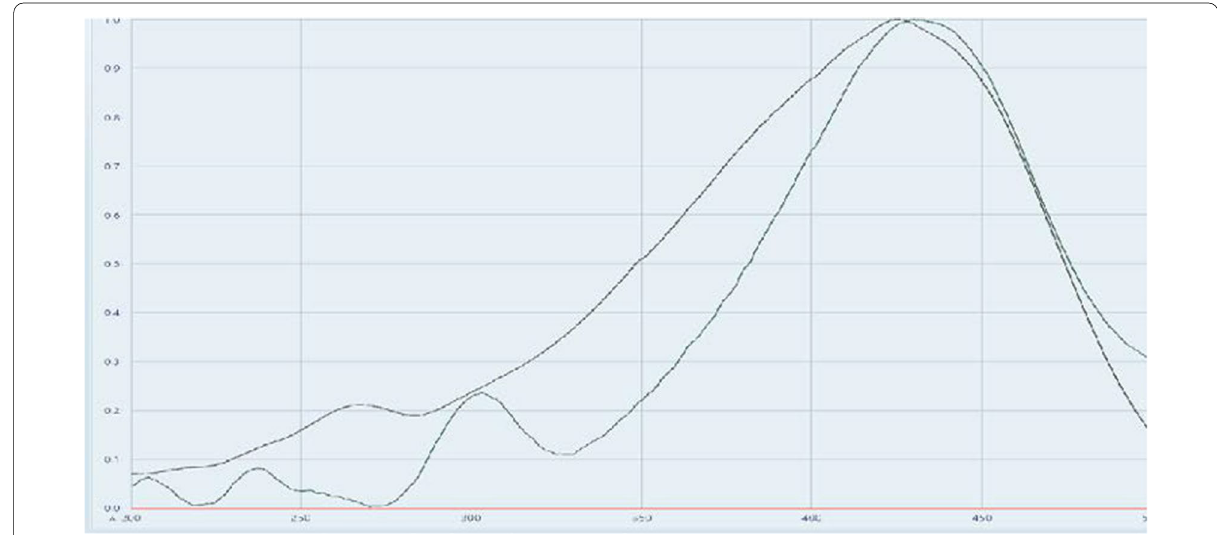
Fig. 5 HPTLC chromatograms of C. longa methanolic fraction with Curcumin